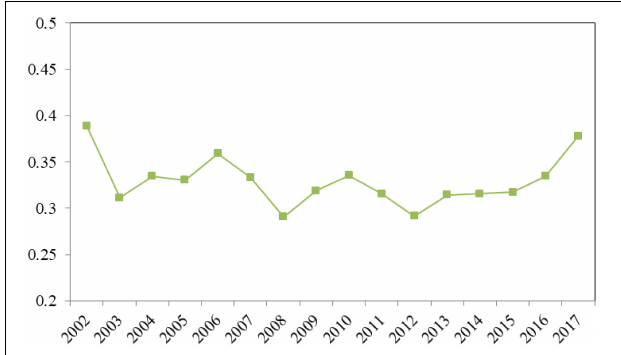
FIGURE 2 | Dynamic evolution of the W-E-F-E nexus in Northwest